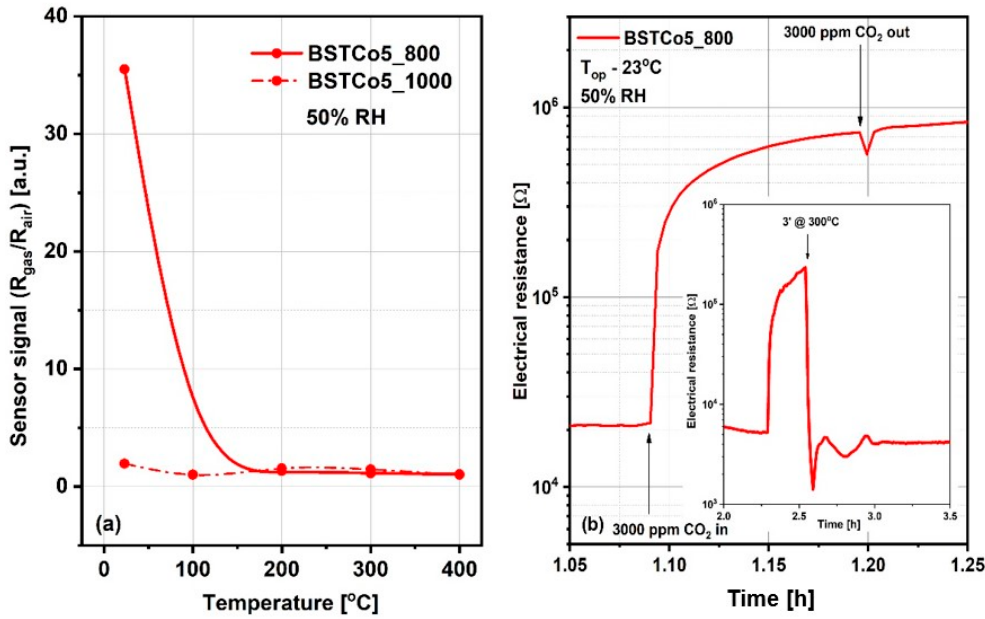
Figure 8. ( a ) Sensor signal for 3000 ppm CO 2 for temperature range 23–400 °C; ( b ) Surface contamination from exposure to CO 2 and the solution of 3 minutes at 300 °C temperature boost applied for its rapid cleaning (b-inset).